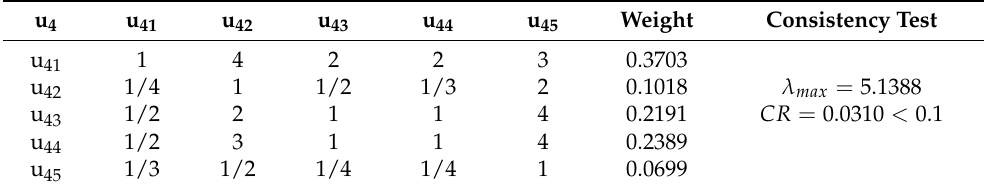
Table 11. The judgment matrix and weights of evaluation indicators under u 4 .